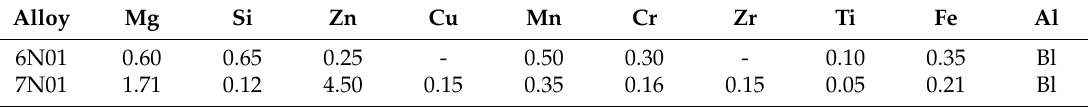
Table 1. Chemical composition of the materials used (mol